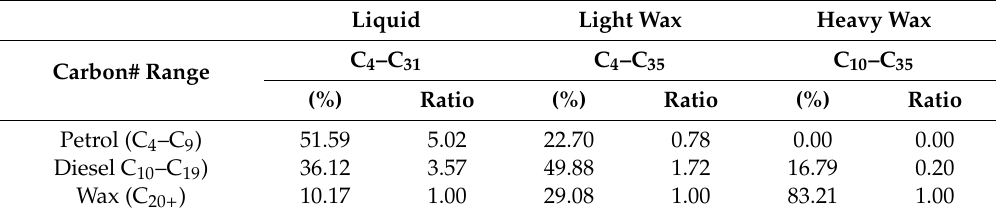
Table 2. Distribution of Hydrocarbons in Each Pyro-oil Sample and Percentile Area Distribution in Petrol, Diesel and Wax